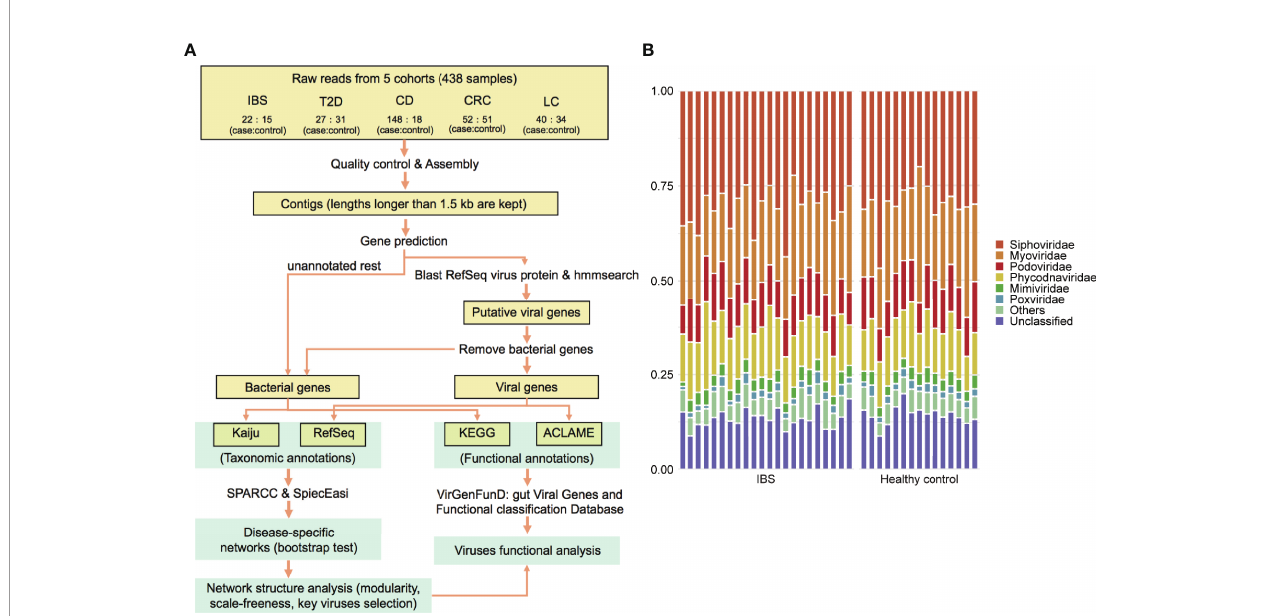
FIGURE 1 | Viruses identi fi ed in the IBS and corresponding healthy controls. (A) Work fl ow of the analysis in this paper. (B) Viral composition in family level of each